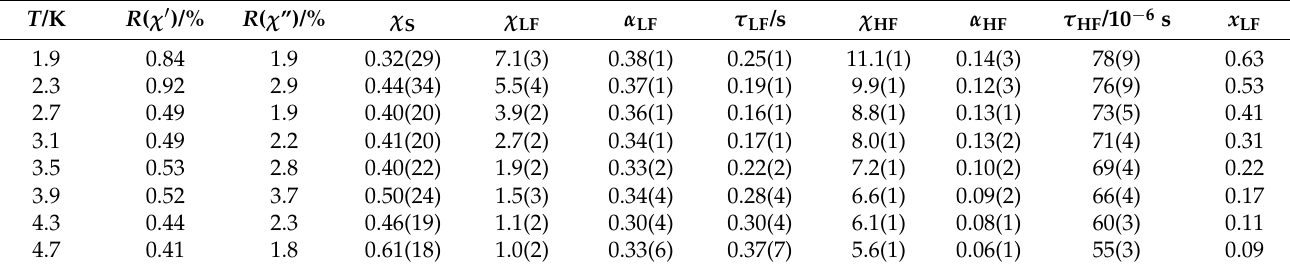
Table 4. Temperature dependence of AC susceptibility components of 1 at B DC = 0.6 T. a